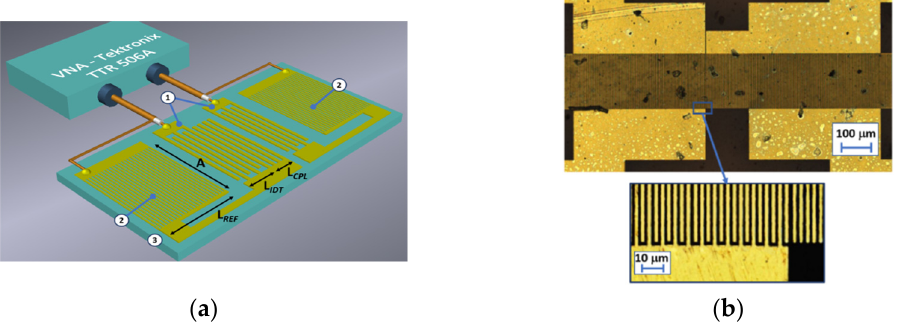
Figure 2. ( a ) Schematic view and ( b ) optical image of the central part of the device #1: 1: IDT, 2: reflector gratings, 3: piezoelectric substrate. Figure 3. The frequency dependencies of ( a ) the S out sensitive film after surface plasma cleaning.